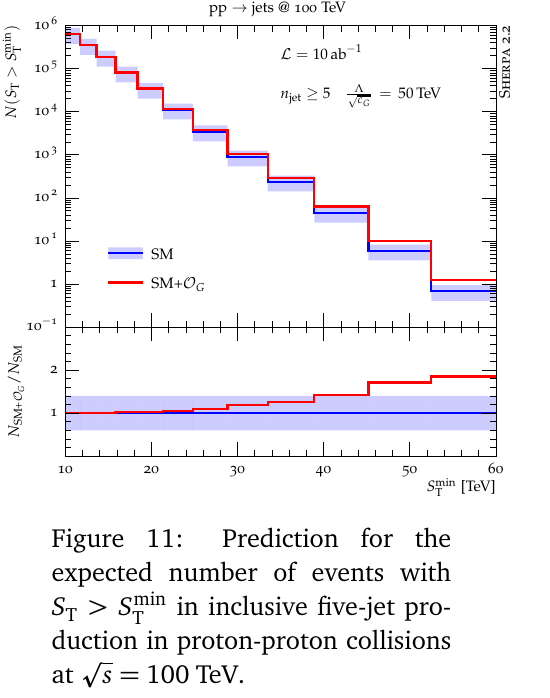
Figure 12: Results for the trans- verse momentum of the Z -boson candidate closest to the nominal Z - boson mass in four-lepton events at the L HC , comparing to data taken from Ref. [ 191 ]